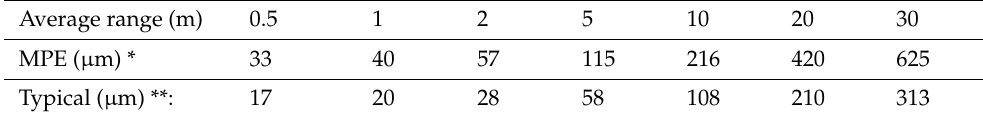
Table 3. APDIS laser radar MV430E average range, MPE, and typical accuracy performance measures. Average range